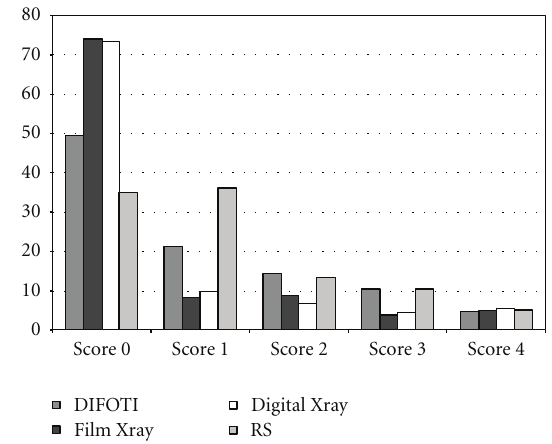
Figure 1: The mean percentage of each detection score for each method, compared to the distribution of the reference standard